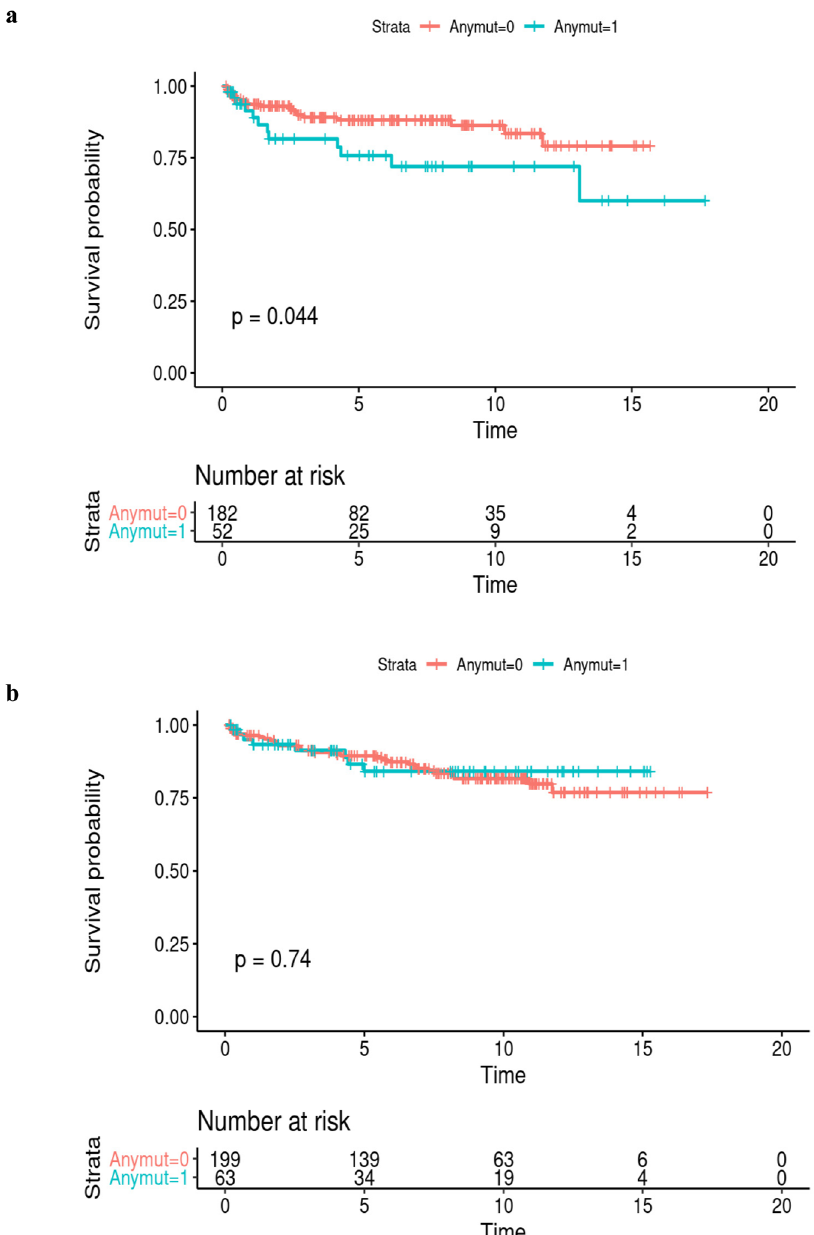
Fig. 5 Kaplan – Meier Estimation Curve of Time to BCR as a Function of DDRG Germline Mutation Status. DDRG mutation status (0, No mutation vs. 1, Any mutation), for CaP patients in AA ( N = 259) (top fi gure, a ) and European Ancestry patients ( N = 272) (bottom fi gure, ( b ). The log-rank p value ( p = 0.044) indicates that there is an association between DDRG germline mutation and BCR over 20 years of clinical follow up after radical prostatectomy in AA men. Source data are provided as a Source Data fi